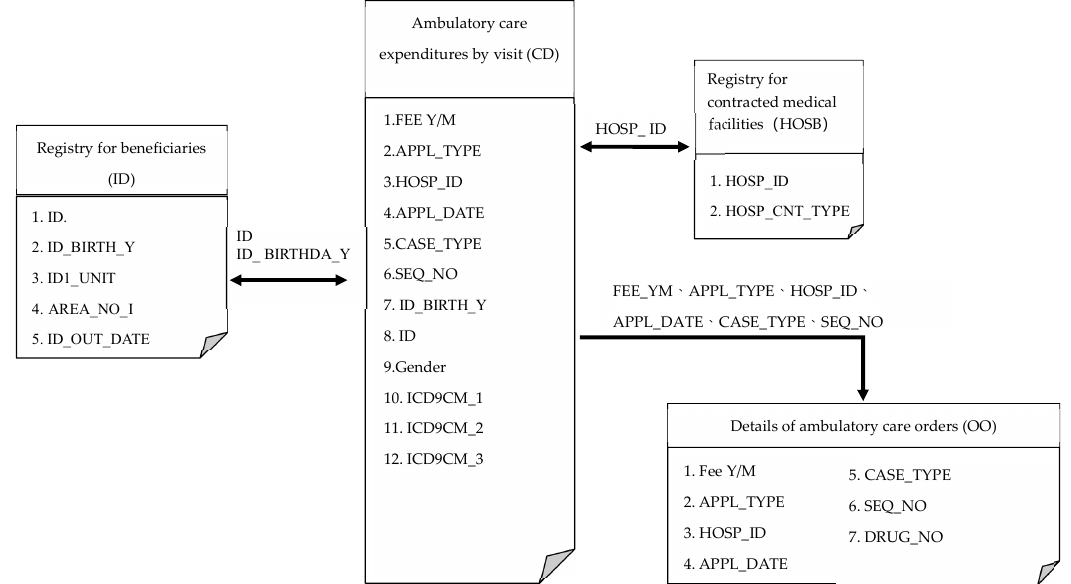
Figure 2. Archives’ name and serial description chart.